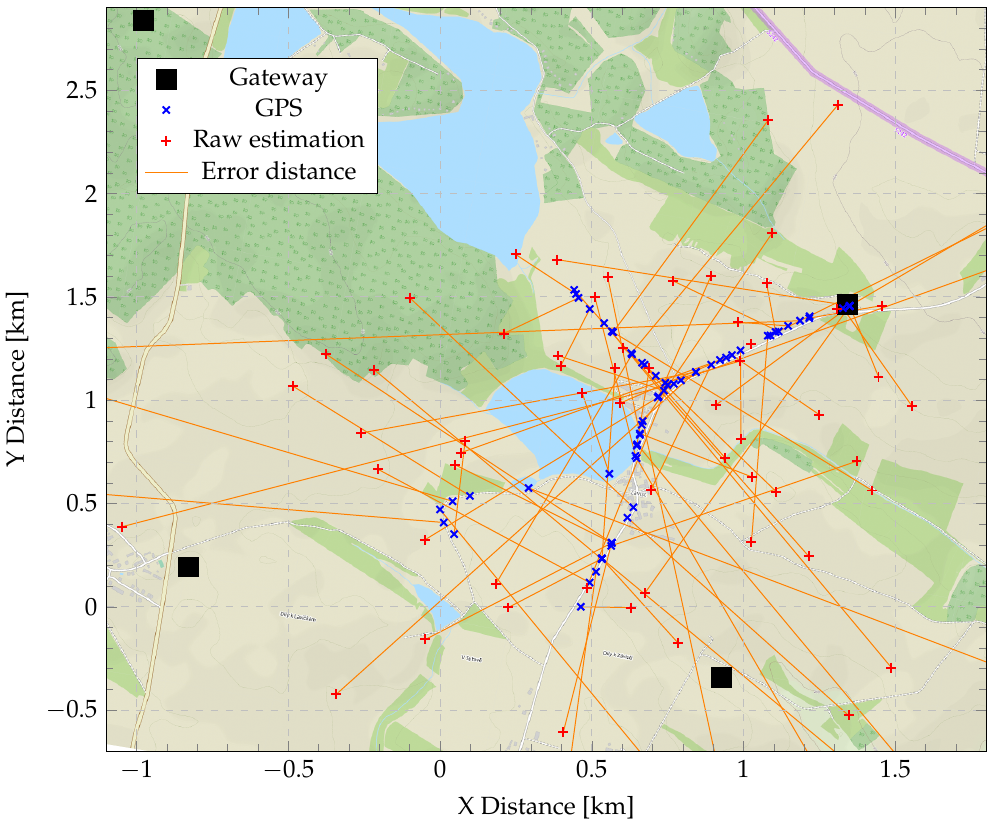
Figure 12. Position estimation (Chan’s and Foy’s algorithms) compared to the correct GPS